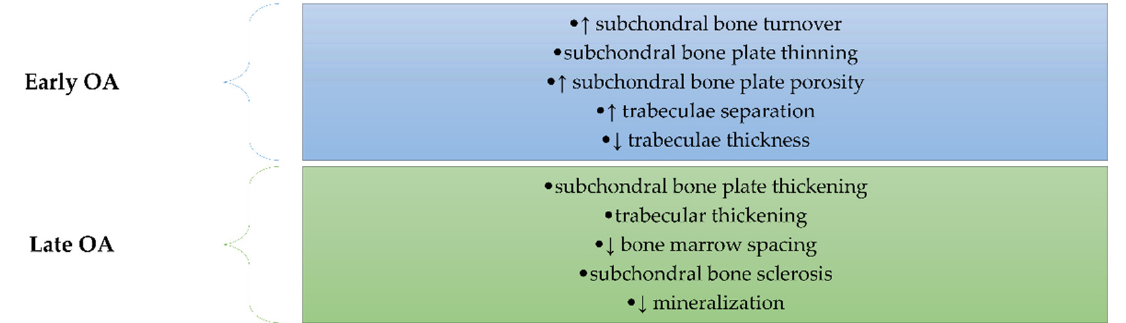
Figure 3. The main structural changes in the subchondral bone occurs in OA depending on the stage of the disease (early or late). In the early stage, there is an increase in subchondral bone turnover characterized by thinning of the subchondral bone plate and by increasing porosity associated with impairment of the trabeculae: thickness decreasing and separation increasing. The late stage of OA is characterized by thickening of the plate and trabecular layers, by decreasing bone marrow spacing, by sclerosis of the subchondral bone, and by decreased mineralization.